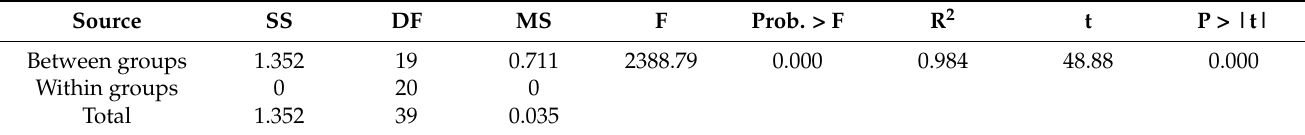
Table 5. Overview of the statistical of effects of solder-pad thickness on